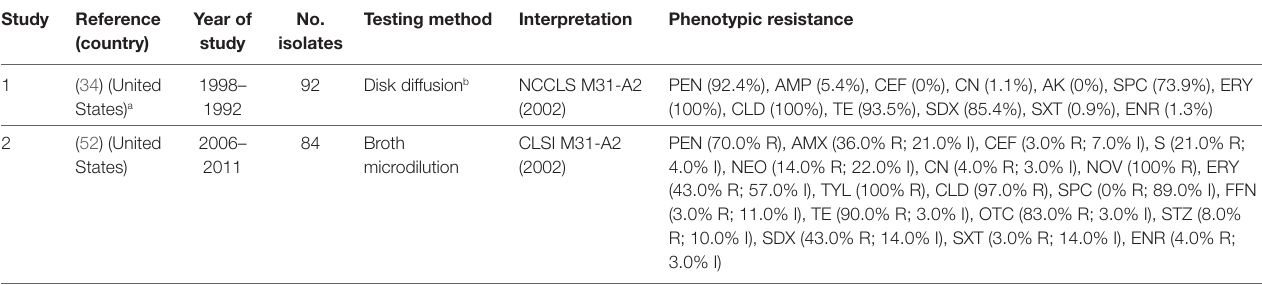
TABLe 5 | Summary of results of two phenotypic studies on antimicrobial resistance of G. anatis and M. haemolytica from poultry.